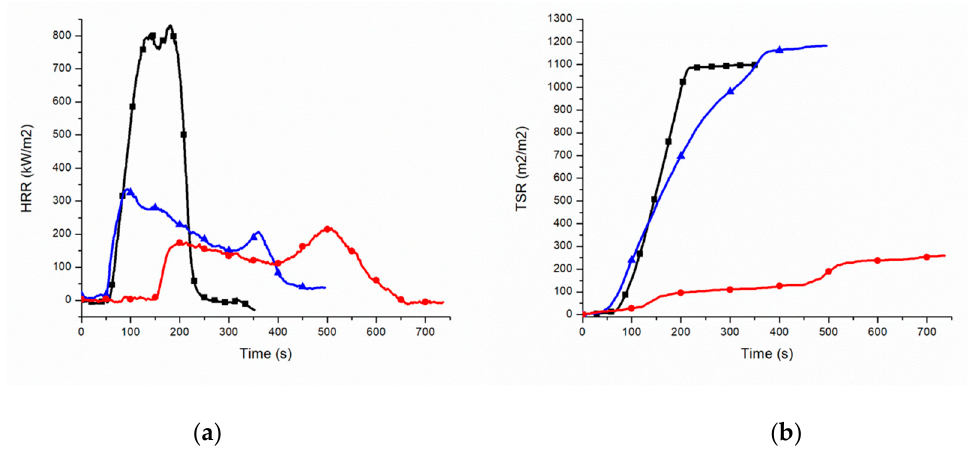
Figure 5. ( a ) HRR PEAL (black square), PEALIFR4031 (blue triangle), PEAL60MH (red circle); ( b ) TSR PEAL (black square), PEALIFR4031 (blue triangle), PEAL60MH (red circle).